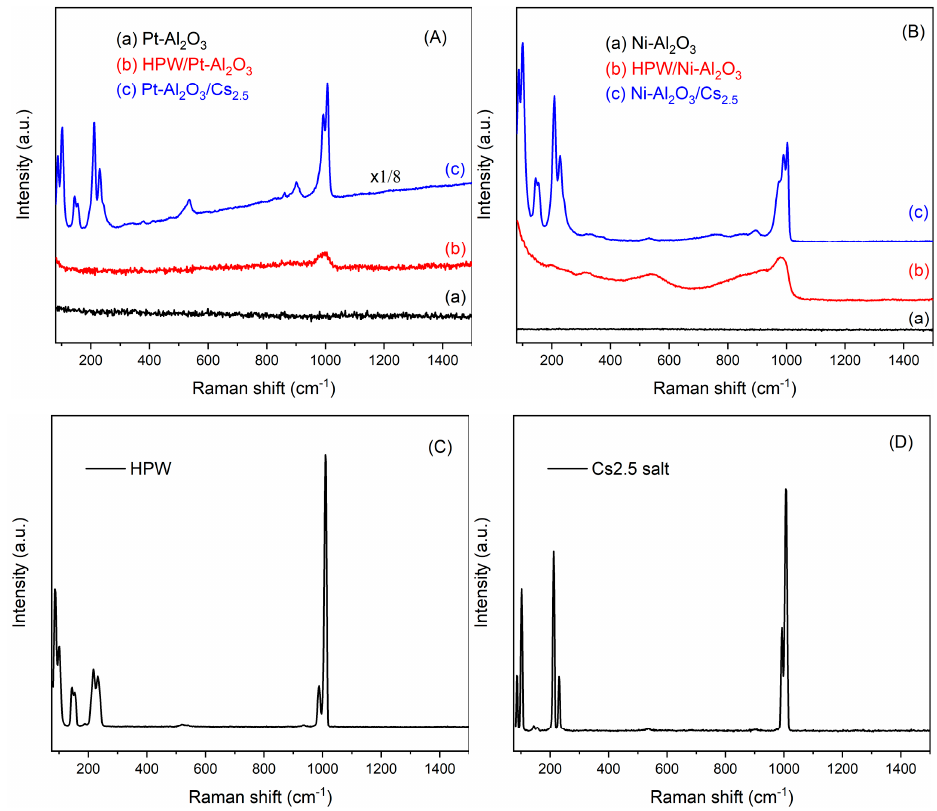
Figure 3. Raman spectra of the different catalysts: ( A ) Pt-Al 2 O 3 series; ( B ) Ni-Al 2 O 3 series; ( C ) HPW; ( D ) Cs 2.5 salt.